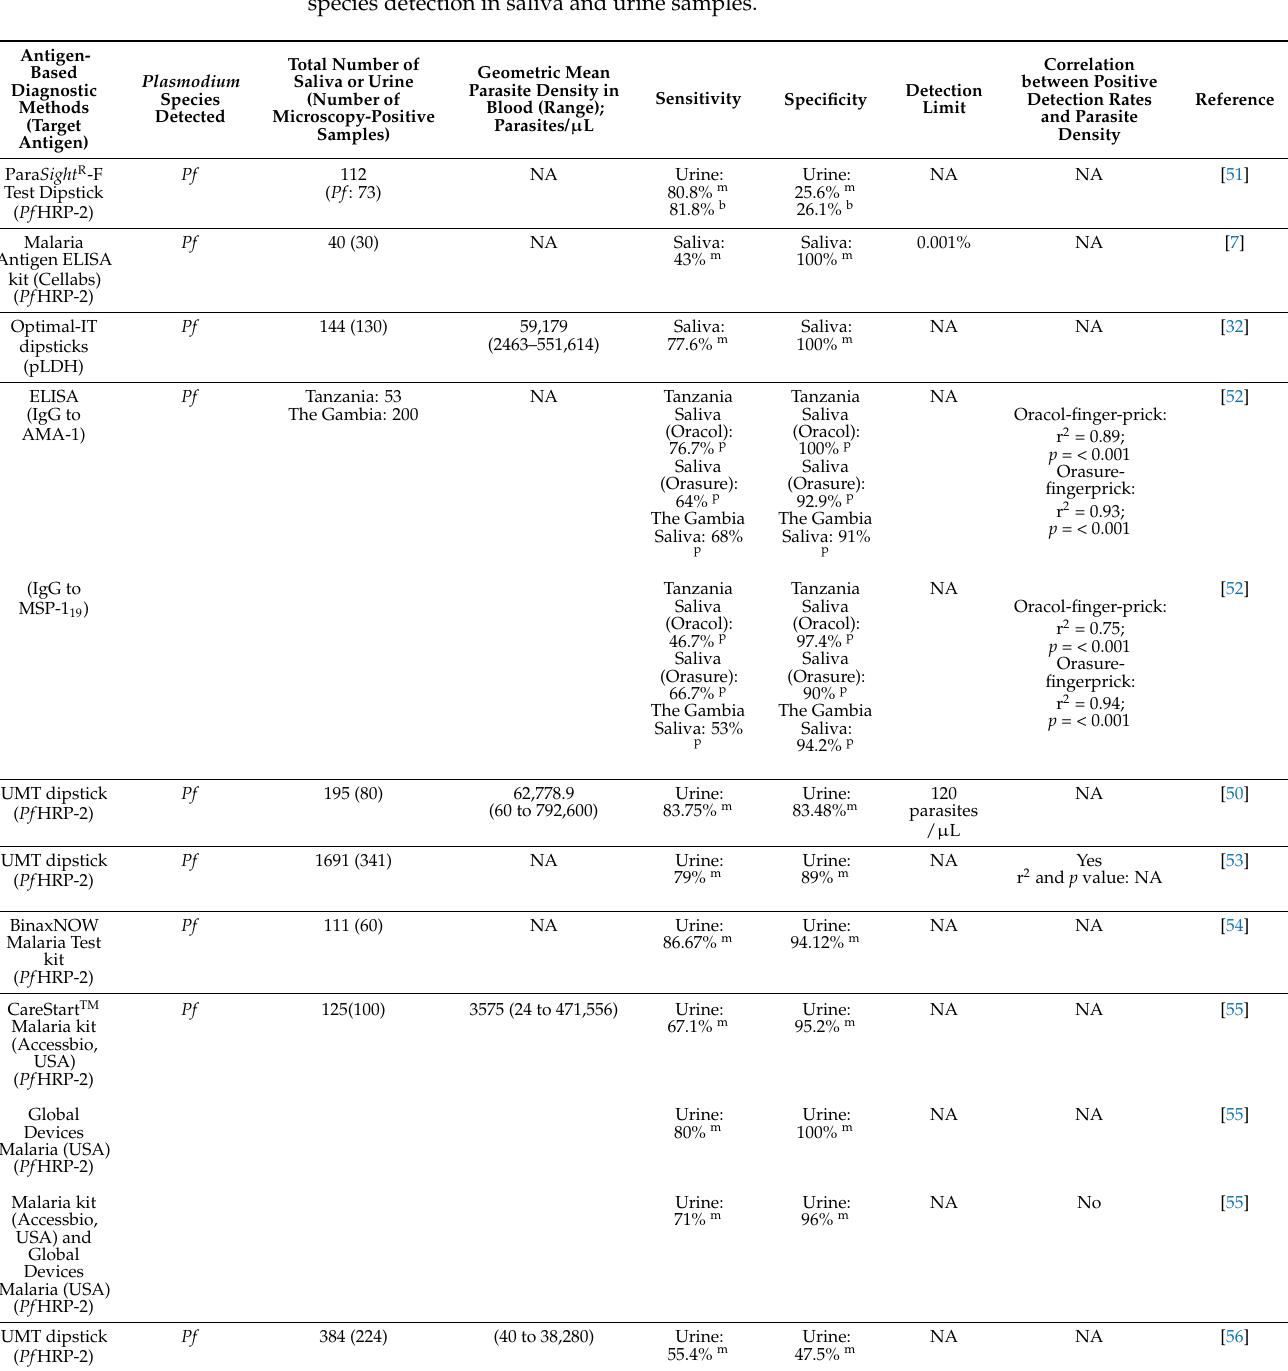
Table 2. Summary of performance of various antigen diagnostic methods evaluated for Plasmodium species detection in saliva and urine